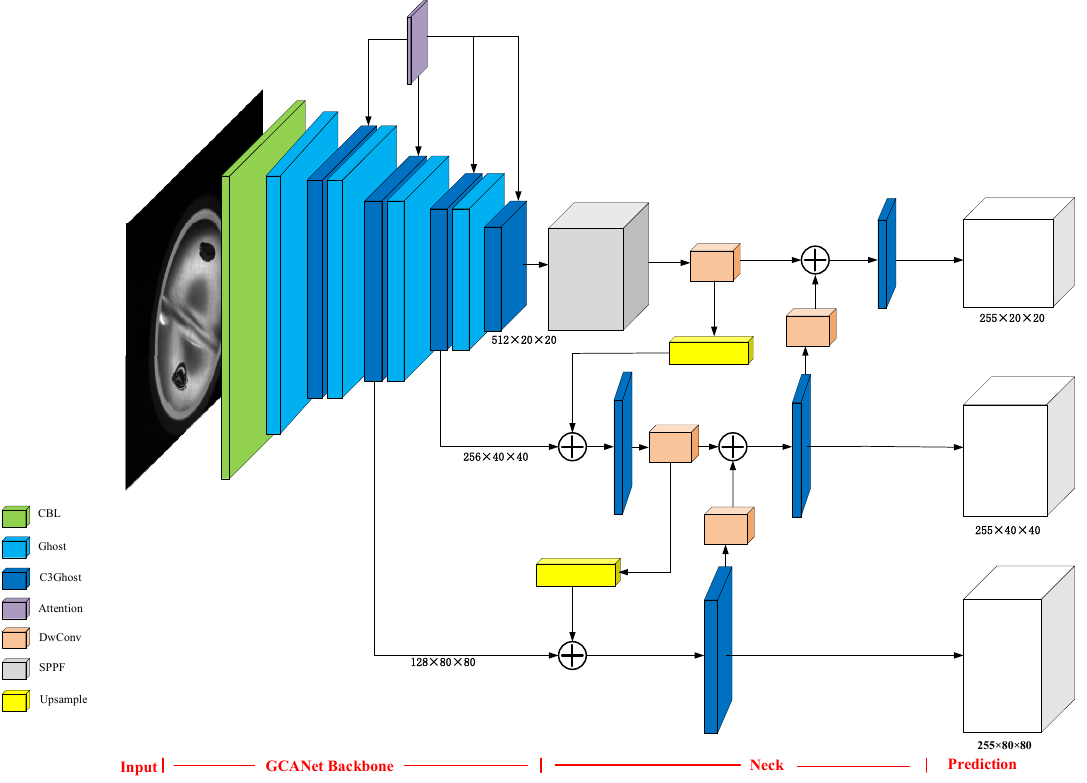
Figure 3. The lightweight model network structure based on YOLOv5s.